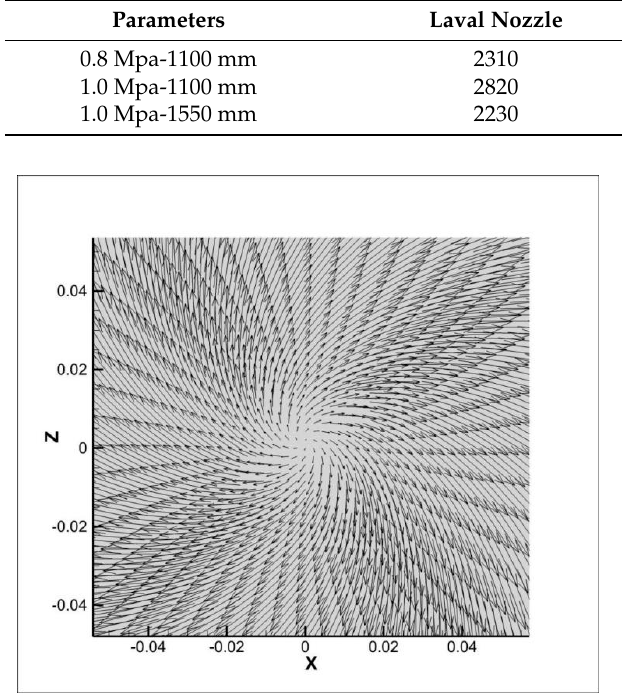
Figure 15. Vector diagram of the interface between oxygen and slag.